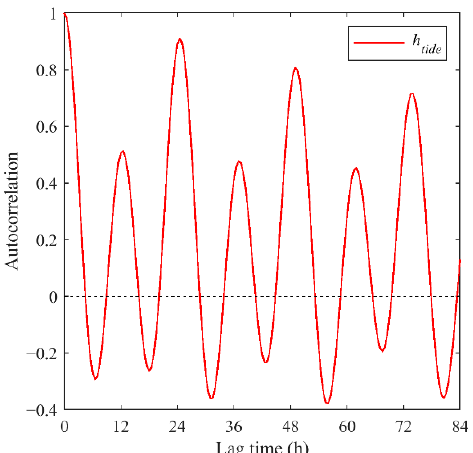
Figure 3. Autocorrelation function of the tide level time series measured at Punta della Salute. After t a = 6 h, the predictions returned to slightly improve with the best performances achieved for a lag time corresponding to the positive autocorrelation peaks, showing evaluation metrics that settled on good values even for t a equal to 72 h. Figure 4 shows the tide prediction with Model I and four different lag times for the high-tide event that took place between 23 and 26 December 2021. The three warning levels are also reported, with high tide between 80 cm and 110 cm, very high tide between 110 cm and 140 cm, and exceptional tide above 140 cm. It should be noted that at 110 cm, 12% of the Venice historical center and Giudecca is underwater and at 140 cm 59% is underwater [47]. During the shown period, two exceptional tide events were measured, respectively on 23 and 25 December, interspersed with a very high tide , measured on 24 December. For the first exceptional tide , the NARX modeling led to a slight overestimation of the tide level of 0.6 cm for t a = 1 h (Figure 4a) and to an underestimation of 3.28 cm, 6.03 cm and 2.40 cm computed respectively for t a equal to 6 h (Figure 4b), 24 h (Figure 4c) and 72 h (Figure 4d). For the second exceptional tide , overestimations of 0.18 cm and 1.80 cm were computed for t a equal to 1 h (Figure 4a) and 6 h (Figure 4b), while underestimations equal to 4.59 cm and 0.23 cm were computed for t a equal to 24 h (Figure 4c) and 72 h (Figure 4d). For the intermediate very high tide , an overestimation of the tide level equal to 1.00 cm was computed for t a = 6 h, while underestimations of 0.48 cm, 7.45 cm and 3.70 cm were computed for t a = 72